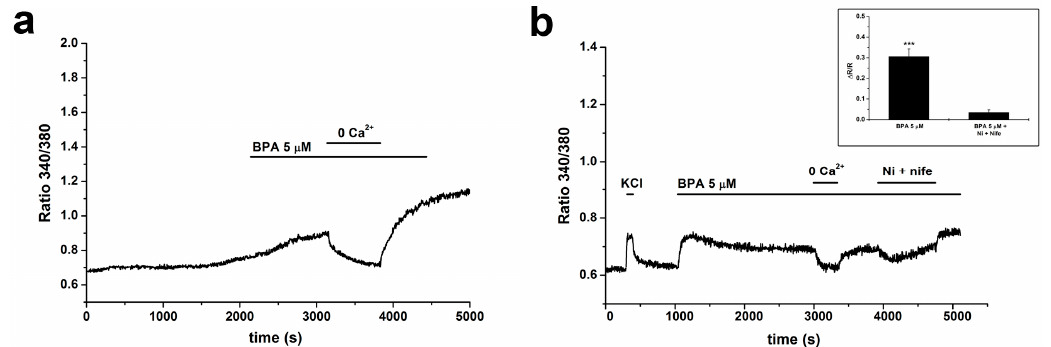
Figure 4. BPA ‐ induced calcium signals are dependent on calcium influx, mainly through voltage ‐ dependent channels. ( a ) Removal of calcium from the extracellular solution completely and reversibly abolished the [Ca 2+ ] i increase in response to 5 μ M BPA. ( b ) Addition of 100 μ M NiCl 2 and 10 μ M nifedipine strongly and reversibly reduced the [Ca 2+ ] i increase during perfusion with 5 μ M BPA. Inset: Response amplitudes during BPA administration with and without addition of blockers of voltage ‐ operated calcium channels. Wilcoxon signed ‐ rank test for paired samples; *** p <